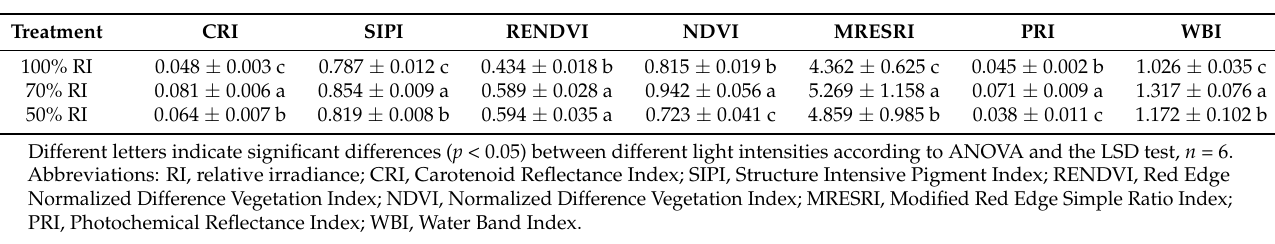
Table 4. Comparison of the spectral parameters of leaves under different light treatments (means ± SDs).